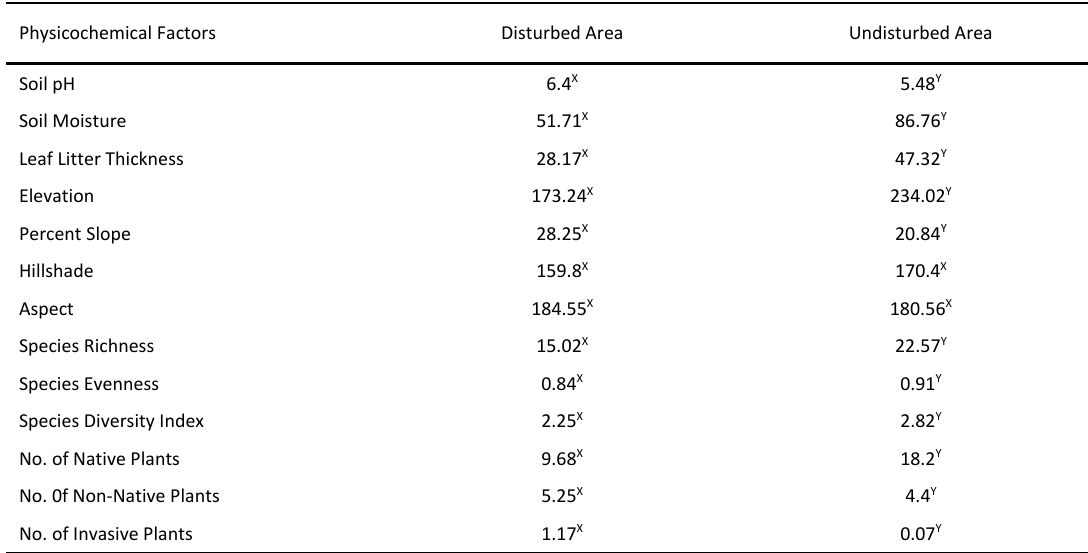
Table 3: Physicochemical factors in disturbed and undisturbed areas